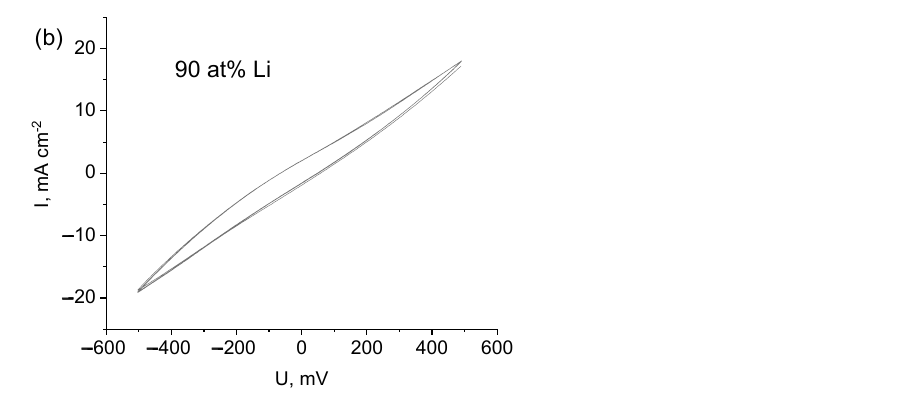
Figure 5. Cyclic voltammetry curves for Li-In | LLZcomp | Li-In cells with 40 ( a ) and 80 ( b ) at% Li at scanning rate of 10 mV s − 1 .